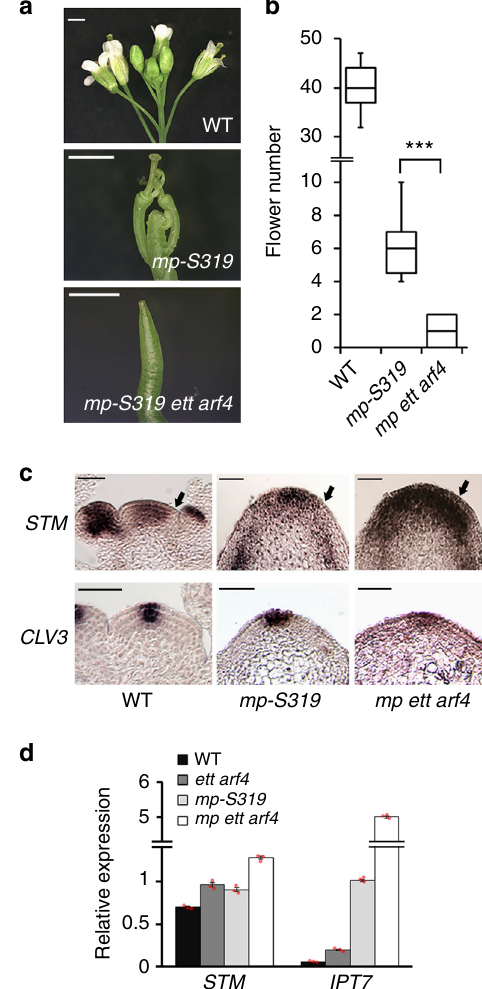
Fig. 1 ETT and ARF4 contribute to initiation of reproductive